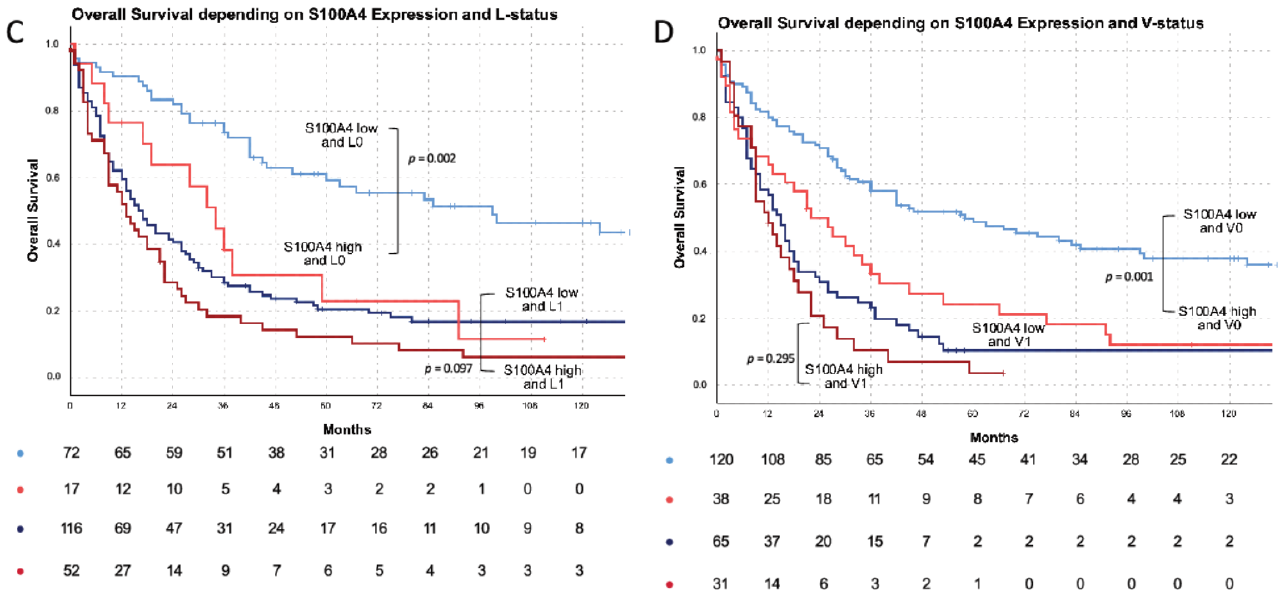
Figure 3. S100A4 subgroup survival analysis: ( A ) S100A4 and stage depending overall survival: in UICC I + II: n = 124 S100A4 low (light blue): 96.3 vs. n = 32 (light red): 63 months mean survival ( p = 0.039) in UICC III+IV: n = 79 S100A4 low (dark blue) 19.2 vs. n = 41 S100A4 high (dark red): 12.7